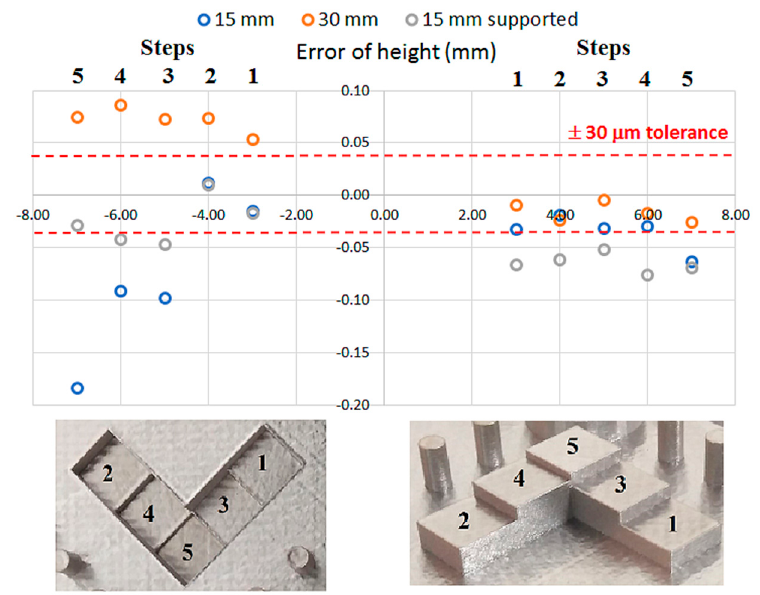
Figure 6. Error of height for the SLMed stairs that go up and down in the NIST part.